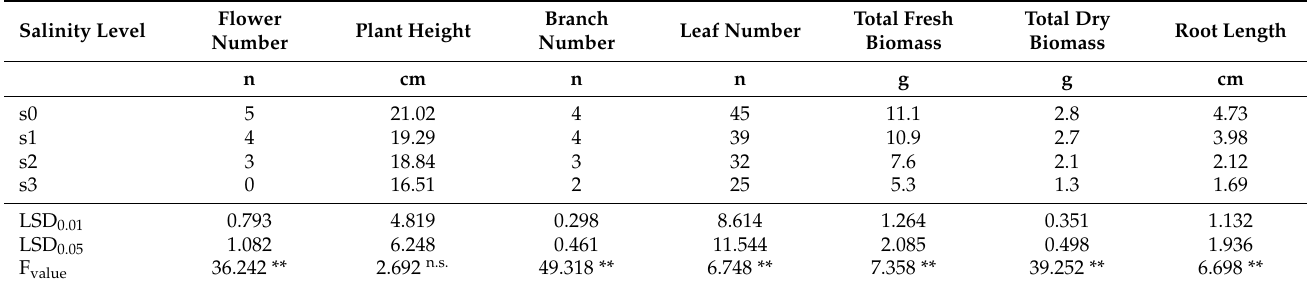
Table 2. Effect of salinity stress treatment on zinnia flower number (n), plant height (cm), branch number (n), leaf number (n), total fresh biomass (g/plant), total dry biomass (g/plant), and root length (cm).